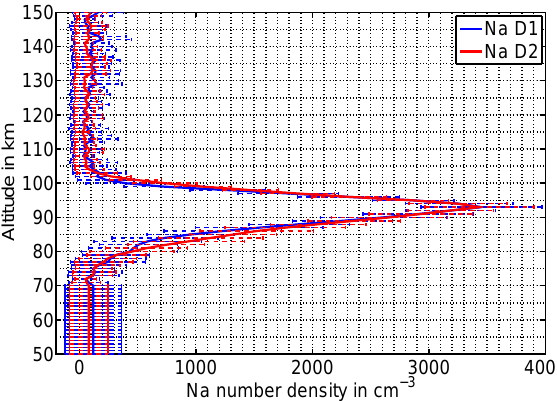
Figure 19. Mean and standard deviation (error bars) of the Na D 1 and D 2 line retrieval for the equatorial SCIAMACHY measure- ments on 20 March